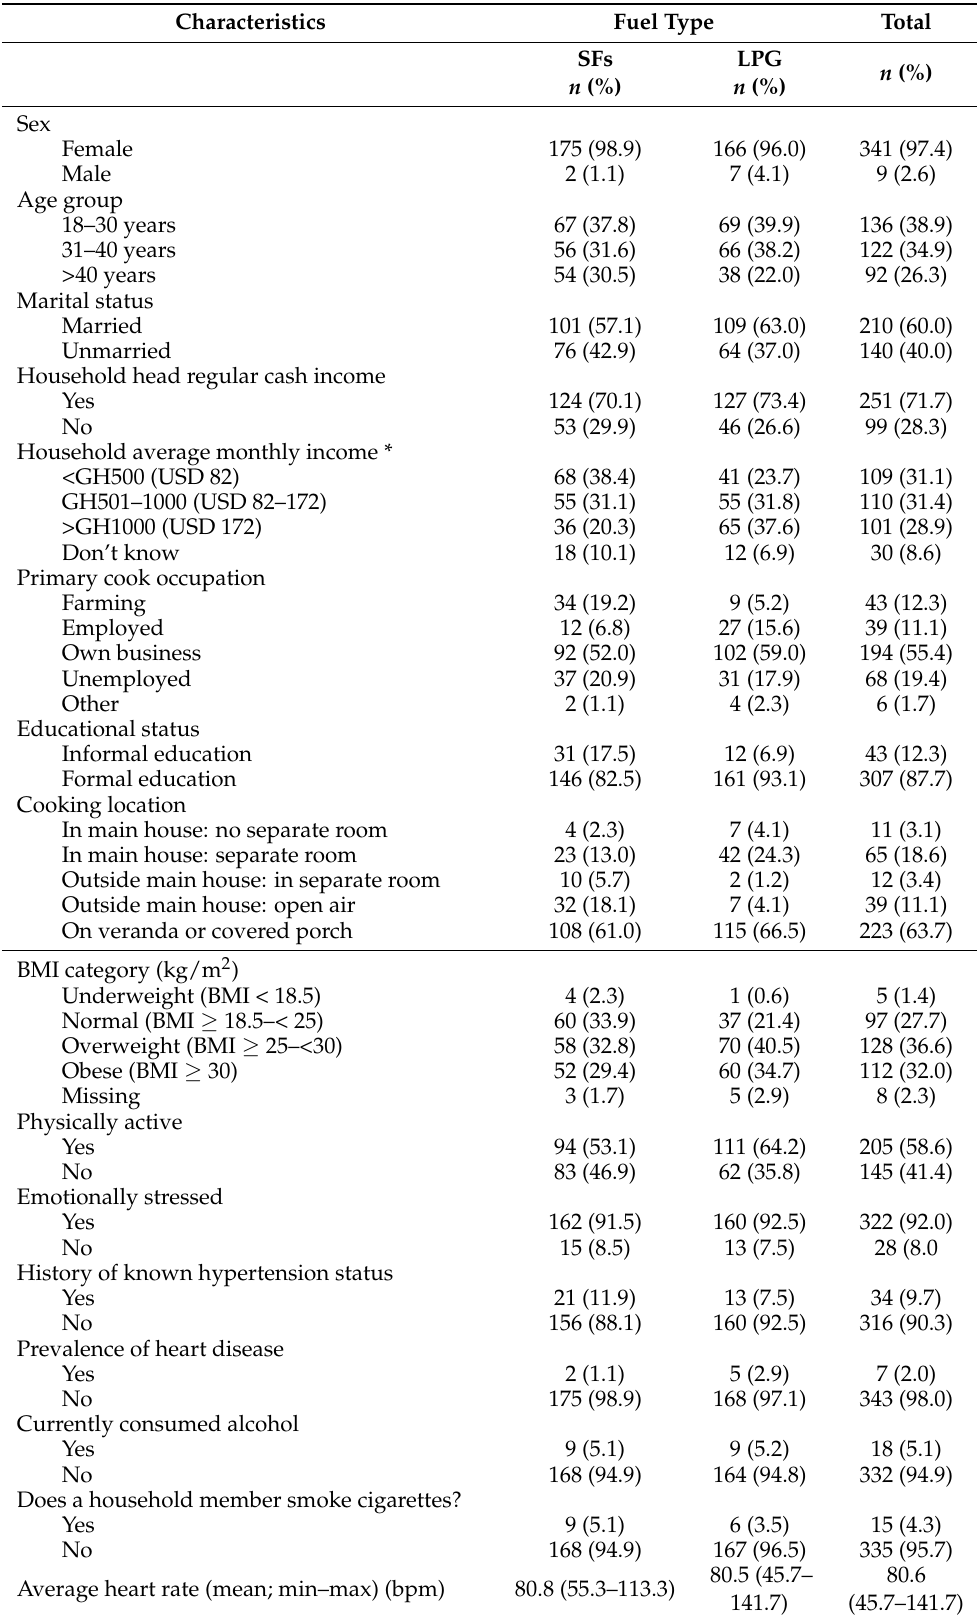
Table 1. Description of respondents’ basic demographic